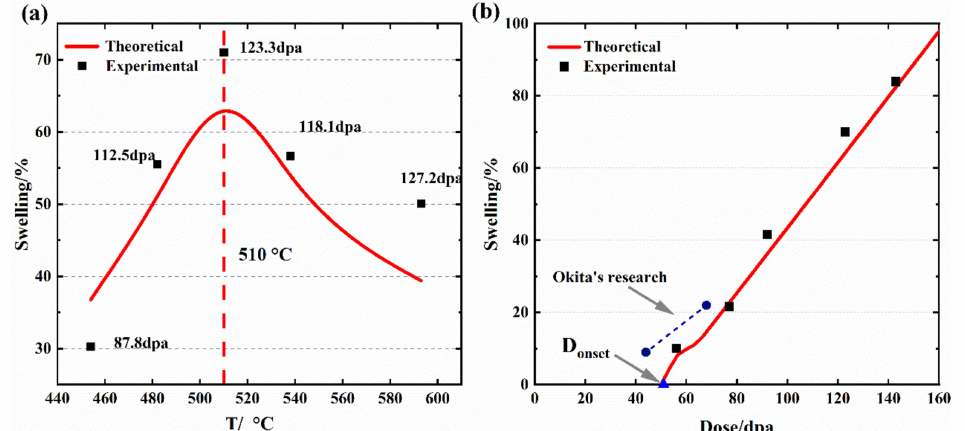
Figure 4. Neutron irradiation swelling of austenitic AISI 316 steel: (a) swelling as a function of temperature with the irradiation dose of 120 dpa, (b) swelling as a function of the dose at 510 ◦ C, where the black squares represent experimental data from [29] and the red line corresponds to the results of theoretical